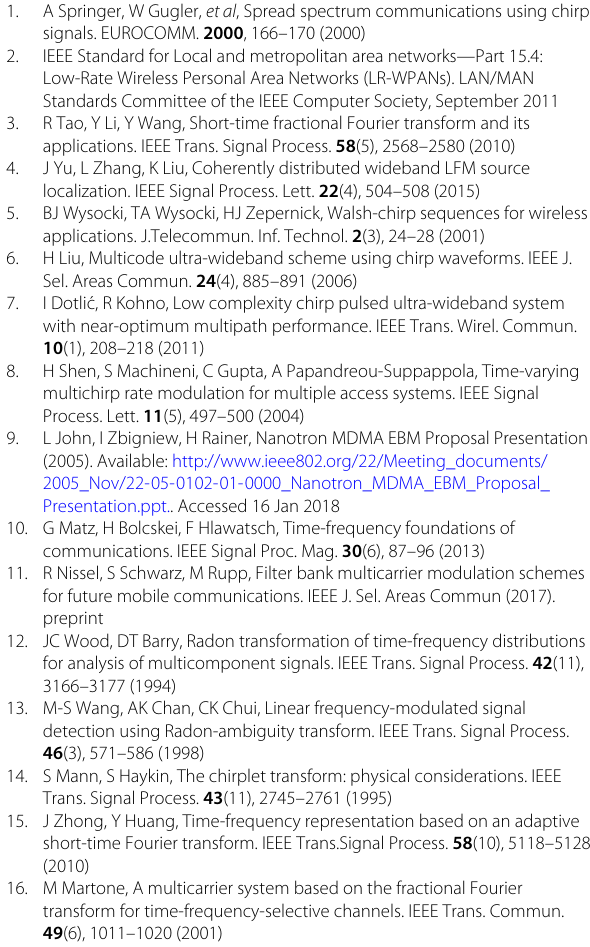
Fig. 9 Performance comparisons in deep fading environment. The figure shows the performance of the MMSE-based algorithm to M -ary chirp-rate signal in deep frequency-selective fading environment. a Normalized frequency response of deep fading channel. b D-BFT detection and MMSE-based